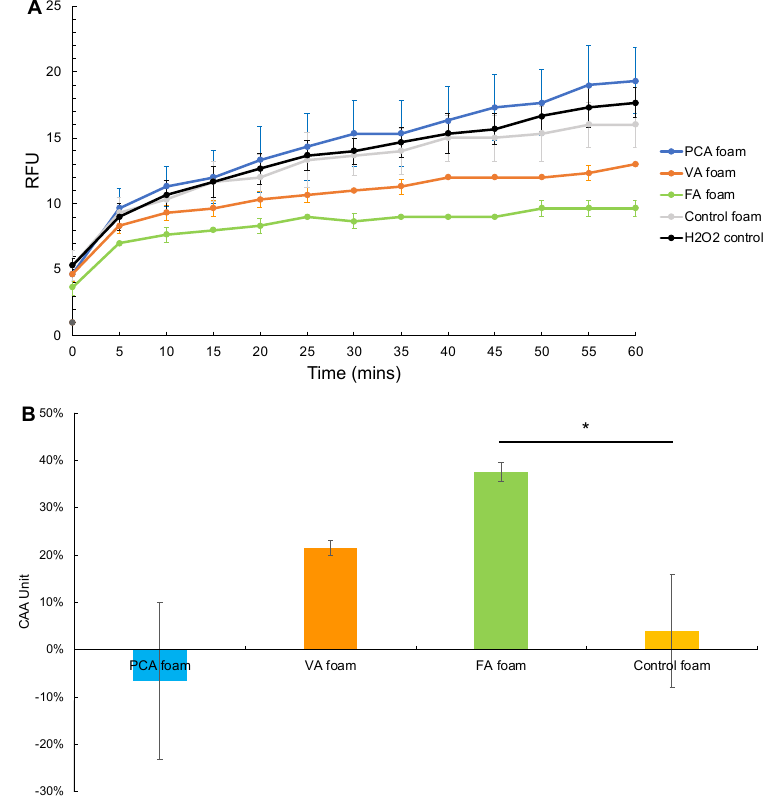
Figure 6. Cellular antioxidant analysis after PA foam and control foam incubation in H 2 O 2 . ( A ) H 2 O 2 - induced oxidation of DCFDA to DCF within Caco-2 cells over 60 min after incubation with SMP foams, ( B ) Cellular antioxidant activity (CAA). n = 3, mean ± standard deviation displayed, * p < 0.05 between H 2 O 2 exposed to FA foam and control foam.